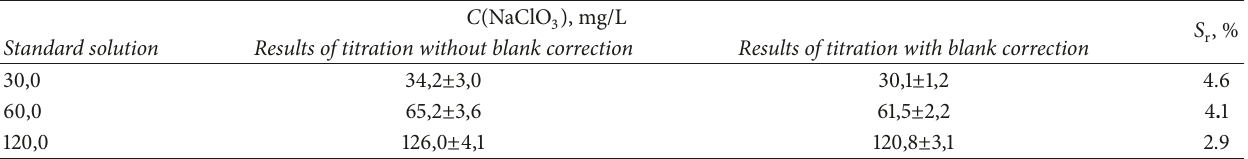
Table 2: Determination of sodium chlorate content without and with reagent blank correction (N = 5, P = 0.95). C (NaClO 3 ), mg/L